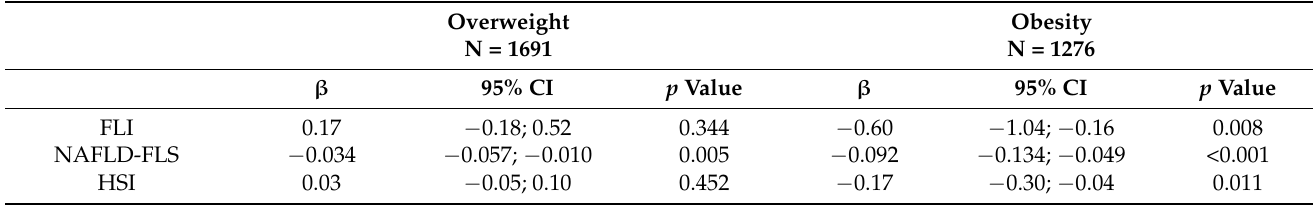
Table 2 reports the association of the Mediterranean diet score with fatty liver indices. Table 2. Association of Mediterranean diet with fatty liver indices in women with overweight and